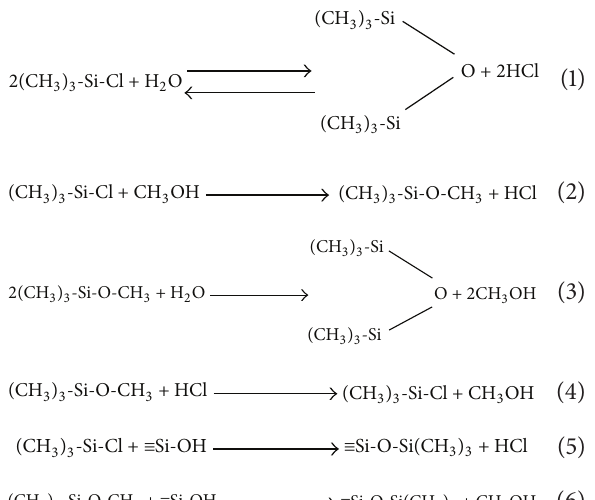
carried out with TMCS in hexane. The governing chemical reactions are shown as